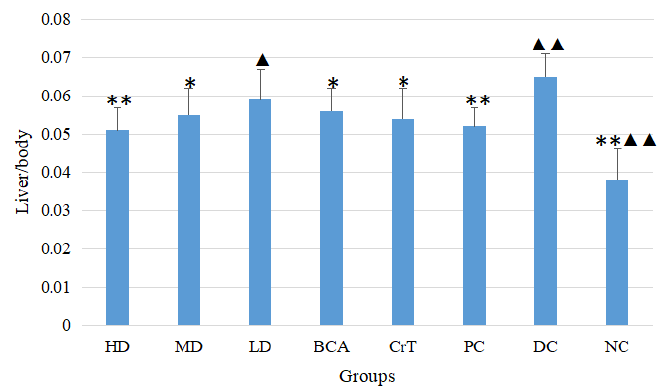
Figure 7. The liver/body ratio after 4 weeks. Values are means ± SD ( n = 7). The differences between these groups and the DC group were statistically significant (denoted by “*” for p < 0.05, “**” for p < 0.01); the differences between these groups and the PC group were statistically significant (cid:78) (cid:78)(cid:78) (denoted by “ ” for p < 0.05, “ ” for p <